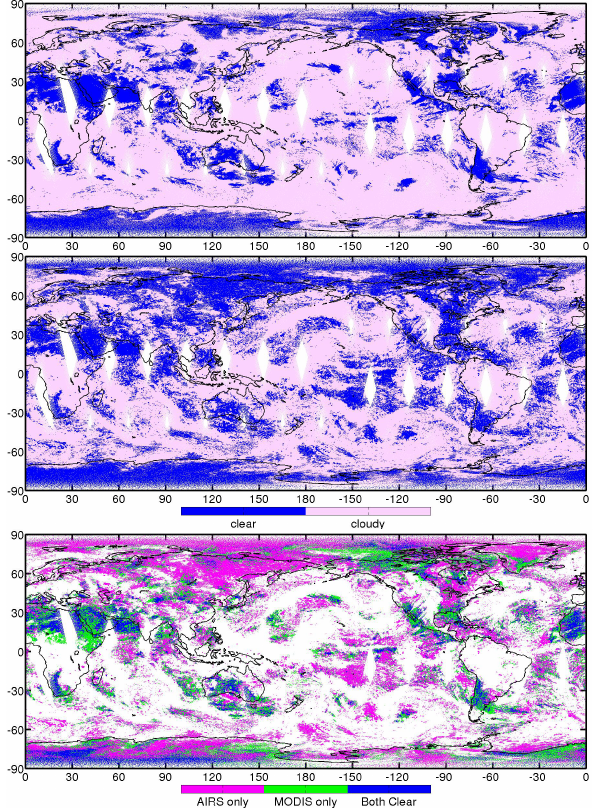
Figure 2. AIRS clear coverage defined by the MODIS cloud mask (top panel); defined by AIRS L2 products where CloudFraction=0 (middle panel); and the differences between the top and middle panel (bottom panel). Fig. 2. AIRS clear coverage defined by the MODIS cloud mask (top panel), defined by AIRS L2 products where CloudFraction = 0 (middle panel), and the differences between the top and middle panel (bottom